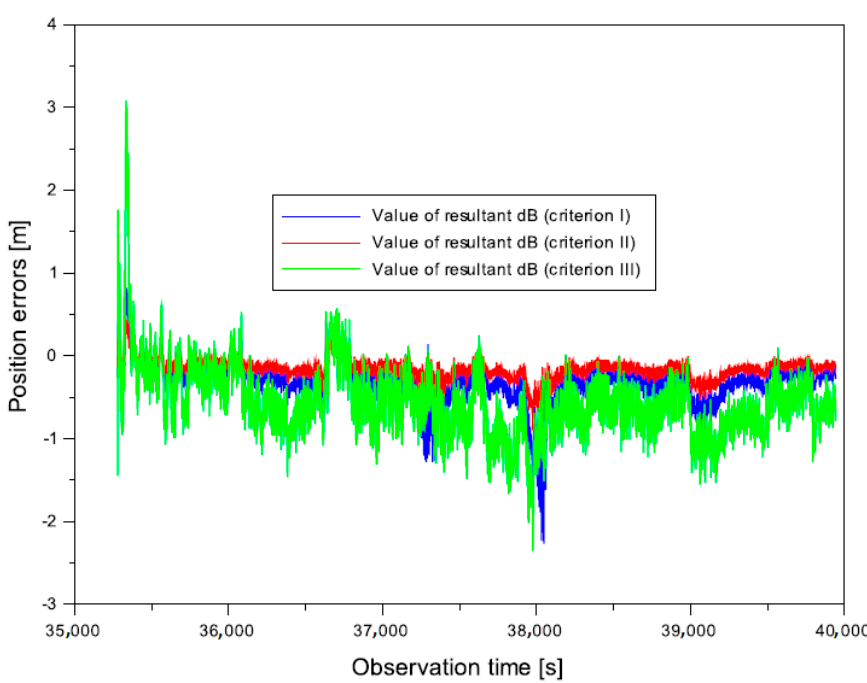
Figure 21. The values of resultant position errors dB .